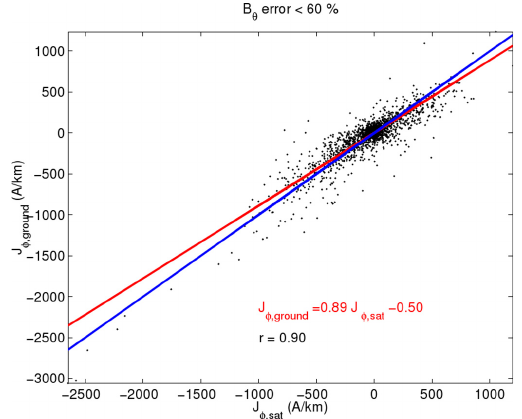
Fig. 9. Scatter plot of J φ determined from ground-based measure- ments (IMAGE) by the 2-D SECS method versus J φ determined from satellite-based measurements (CHAMP) by the 1S SECS method. The ground-based J φ is averaged over the approximately 4min it takes for the satellite to pass over IMAGE. In red is shown a line fitted to the points, and the linear correlation coefficient is denoted by r . A line passing through the origin with a unit slope is drawn in blue. To create this plot, data from 124 satellite passes over IMAGE with an error smaller than 60% during 2001 and 2002 were used. Reproduced from Fig. 5 of Juusola et al.